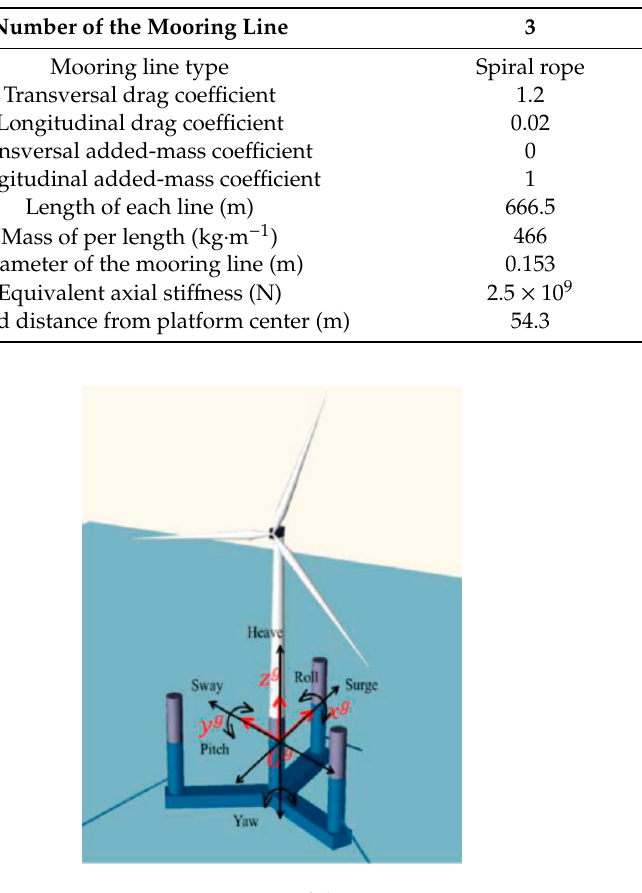
Figure 6. Overview of FAST used in the fully coupled analysis. During the analysis, two additional modules were introduced. One is ANSYS-AQWA [40], which was used to calculate the hydrodynamic coefficients of the braceless semi-submersible platform in the frequency domain, including the added mass, potential damping, and first-order wave exciting forces. The panel mesh model of the braceless semi-submersible platform below the SWL is shown in Figure 7. The results of hydrodynamic coefficients were converted to the WAMIT [41] format to perform fully coupled time-domain simulations in FAST. The other is TurbSim [42], which was used to generate the 3D turbulent wind velocity fields which were input into AeroDyn.